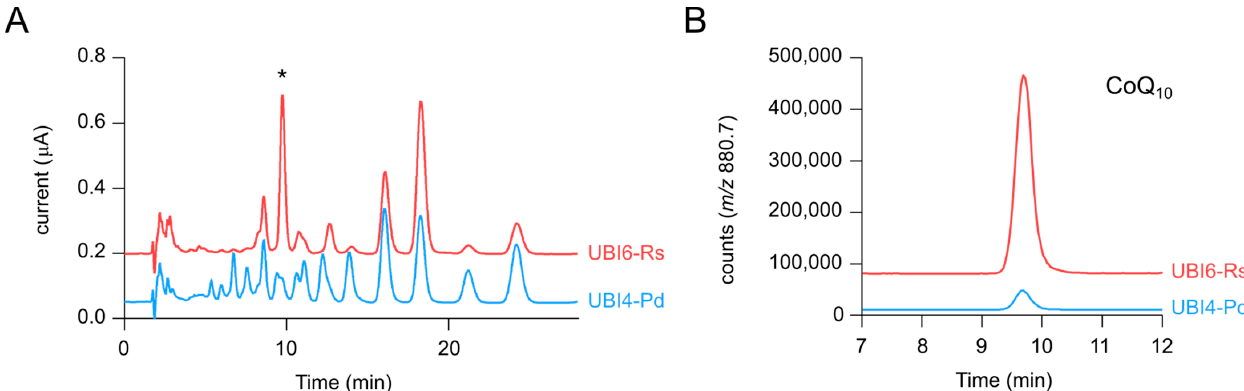
Figure 4. ( A ) Overlay of ECD chromatograms from extracts of strains UBI4-Pd and UBI6-Rs. * indi- cates the peak corresponding to CoQ 10 . ( B ) Overlay of SIM chromatograms for CoQ 10 (NH 4+ adduct m/z = 880.7). Chromatograms are representative of three independent samples. Table 3. Ratios of relative peak areas from mass spectrometry analysis and CoQ 10 biomass yields, titers, and volumetric productivities for the strains UBI6-Pd, UBI6-At, and UBI6-Rs. In addition, UBI6-Rs was cultivated in a BioLector microcultivation system in CGXII medium (same as before) and WSCH medium.